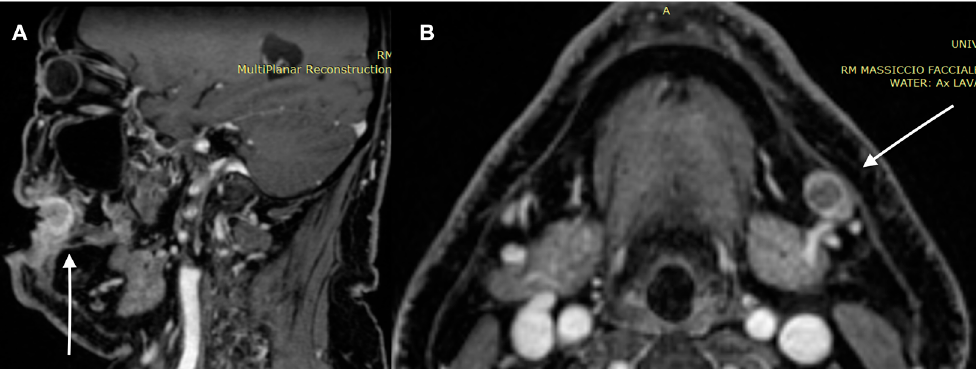
Figure 6. MRI examination of the previous patient. ( A ) Enhanced MRI imaging: sagittal section. The lesion shows high intensity reinforcement in the contrastographic study image. ( B ) Axial section lymph node. Metastatic lymph node with high intensity reinforcement in the contrastographic study image.